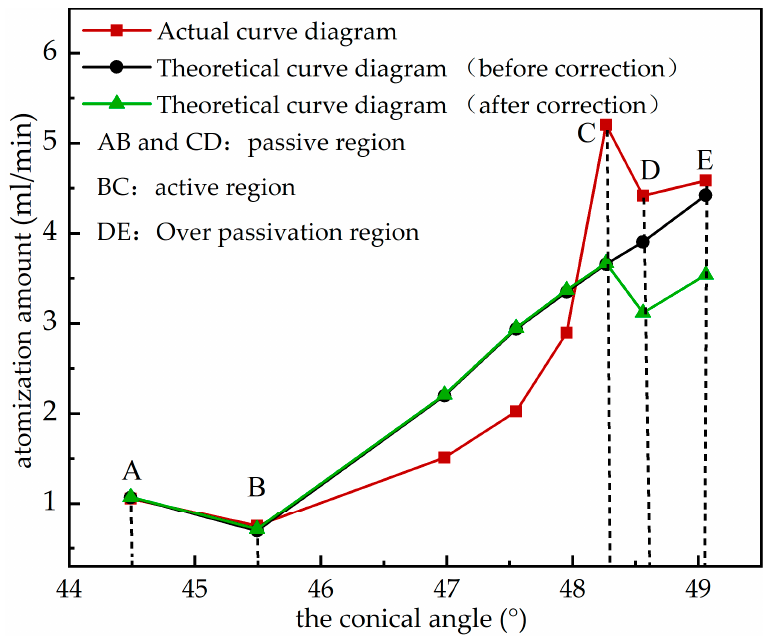
Figure 10. Atomization amount under different conical angles.